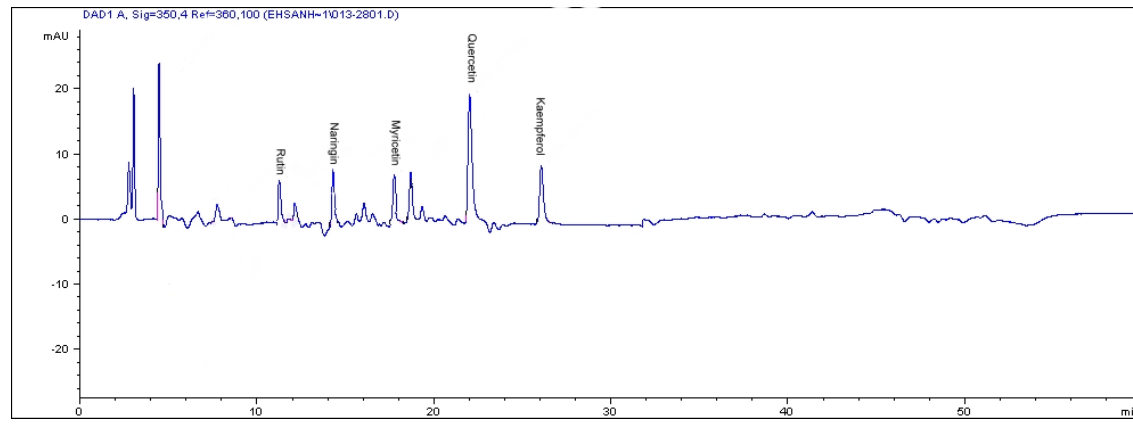
Figure 1. The RP-HPLC chromatogram of flavonoid compounds in the leaves of Labisia pumila var. pumila. Identification of compounds: rutin, naringin, myricetin, quercetin and